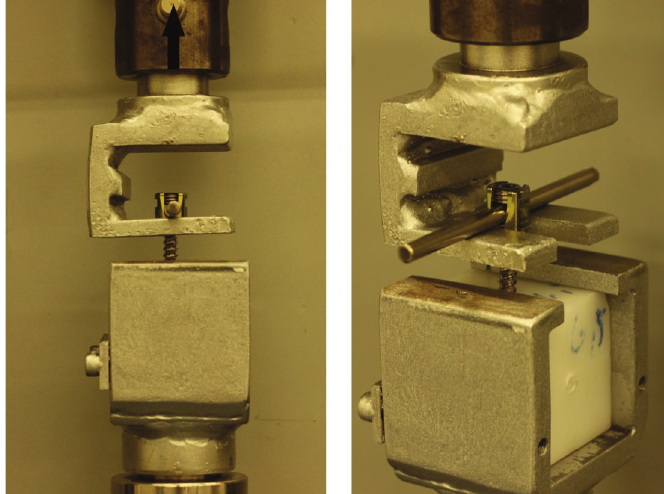
Figure 2: Axial pullout test setup.